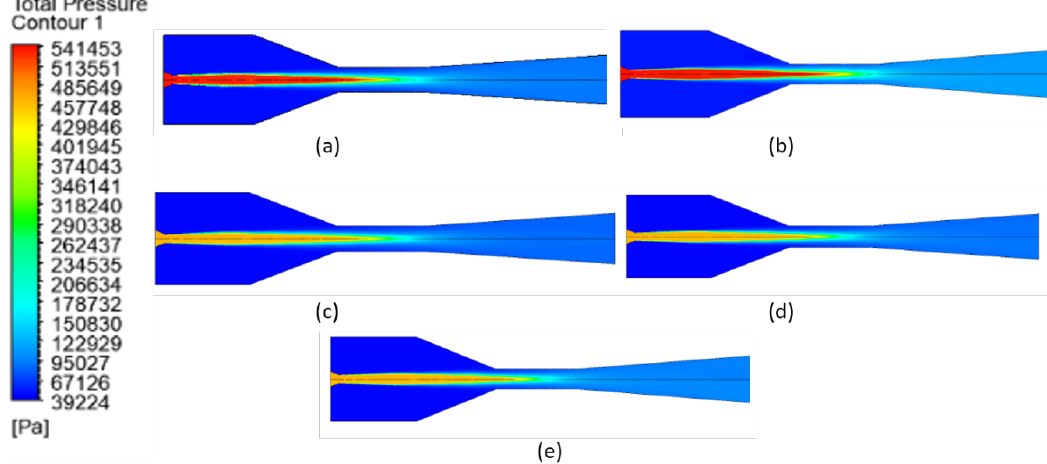
Figure 10. Total pressure contours ( a ) AD Geometry P e = 0.047 MPa, P g = 0.538 MPa; ( b ) AA Geometry P e = 0.047 MPa, P g = 0.538 MPa; ( c ) AD Geometry P e = 0.04 MPa, P g = 0.465 MPa; ( d ) AC Geometry P e = 0.04 MPa, P g = 0.465 MPa; and ( e ) AB Geometry P e = 0.04 MPa, P g = 0.465 MPa.